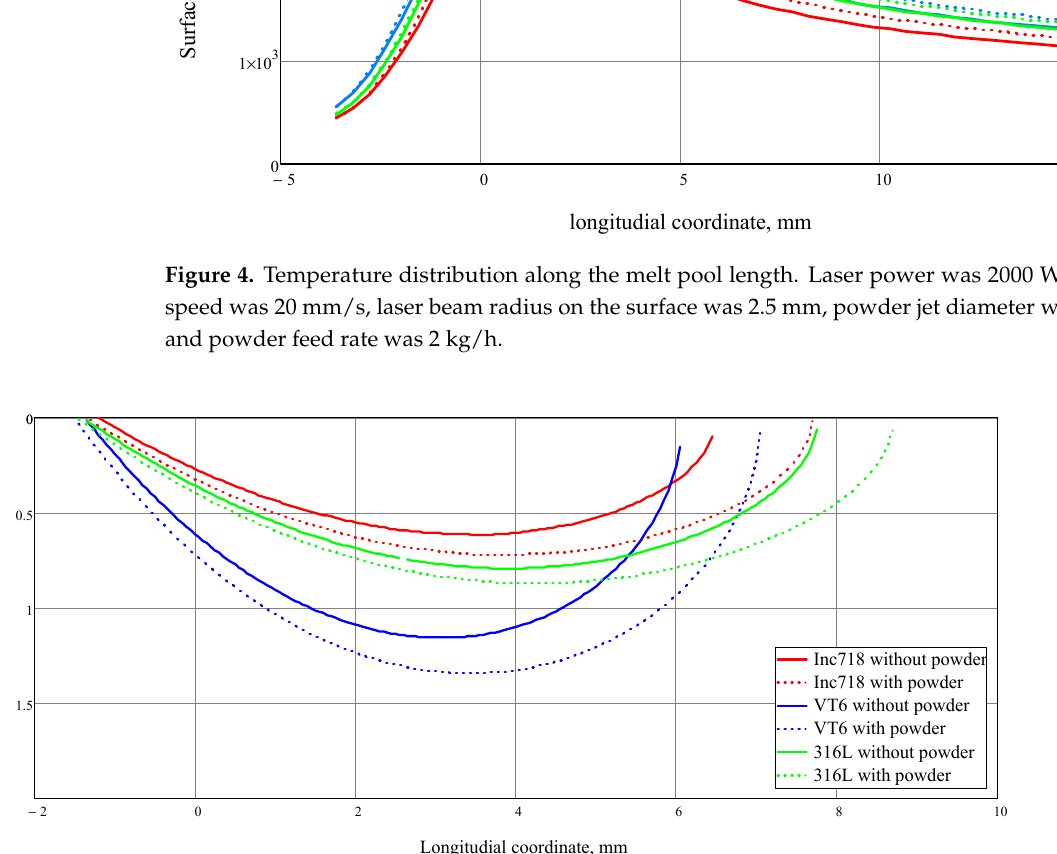
Figure 5. Melt pool shape. Laser power was 2000 W, motion speed was 20 mm/s, laser beam radius on the surface was 2.5 mm, powder jet diameter was 3 mm, and powder feed rate was 2 kg/h.